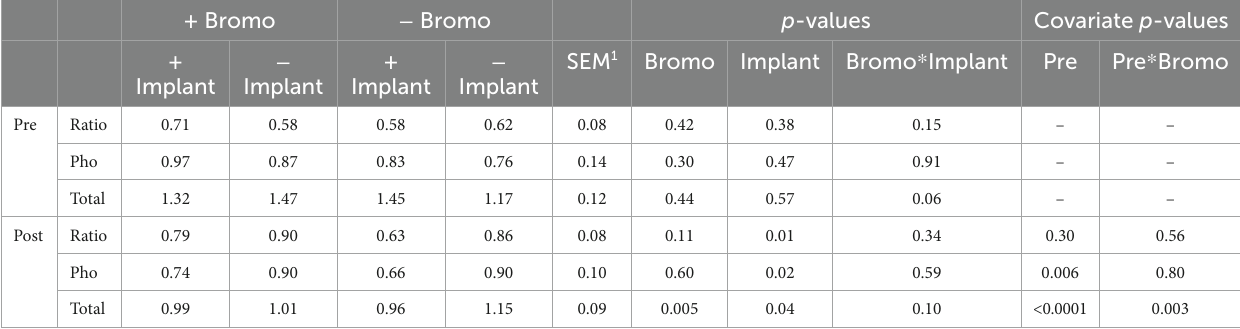
TABLE 8 Relative abundance in arbitrary units of activated, phosphorylated, and total 4E-BP1 proteins in muscle of steers treated with bromocriptine and estradiol/TBA implants before (pre) and in response (post) to an IV glucose bolus. + Bromo − Bromo p -values